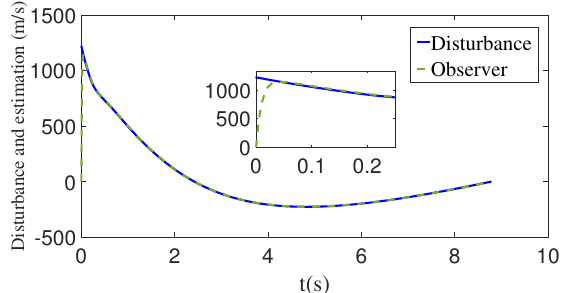
Figure 4. The disturbance d and its estimation ˆ d with constant